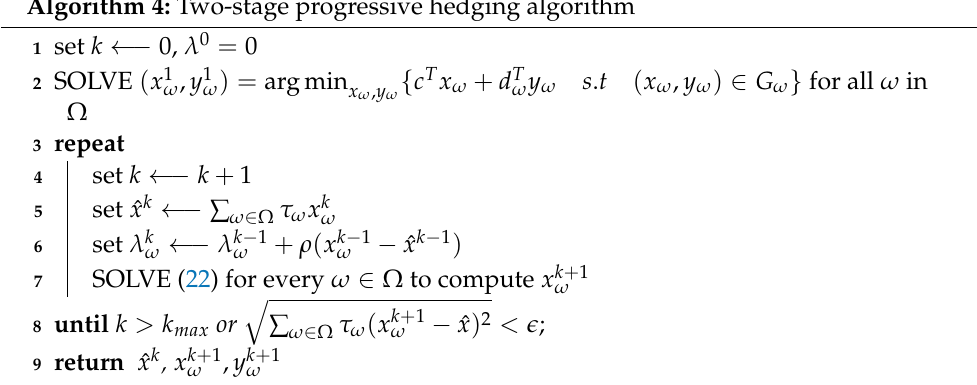
Algorithm 4: Two-stage progressive hedging